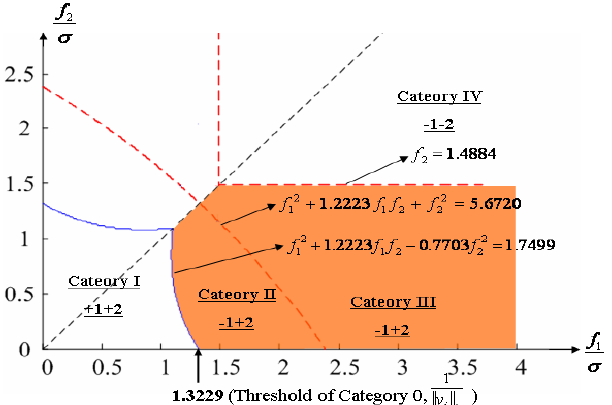
Figure 8. Region of categories I through IV for 1 st and 2 nd faulty sensors for configuration